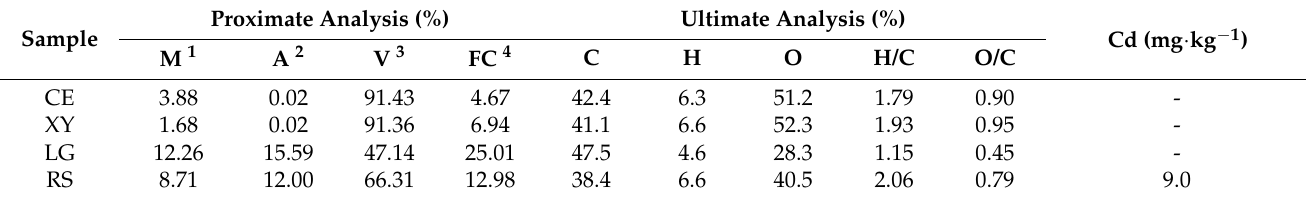
Table 1. Proximate and ultimate analysis (wt.%) of three model components and rice straw.